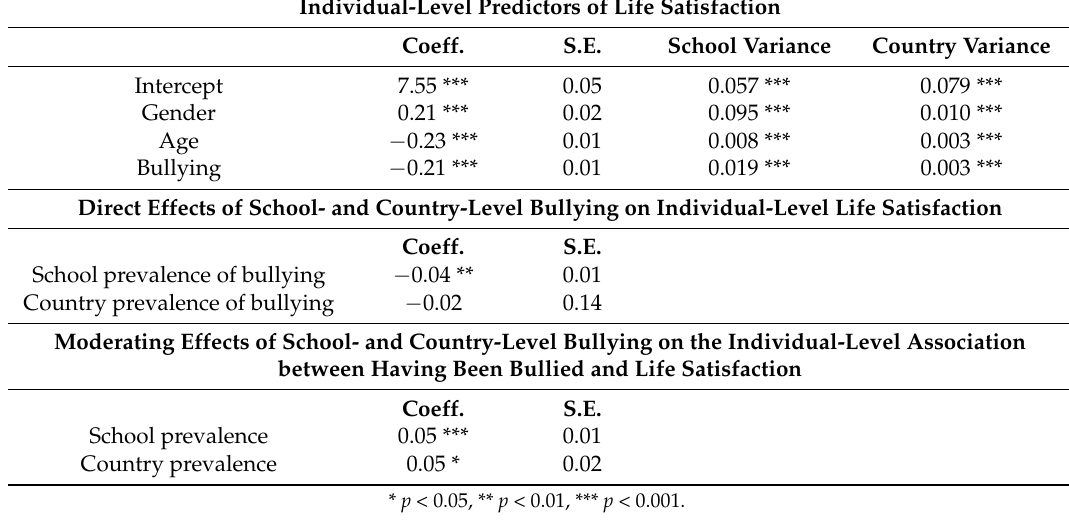
Table 2. Multi-level analysis of life satisfaction and bullying for 11- to 15-year-old students in 35 countries, HBSC